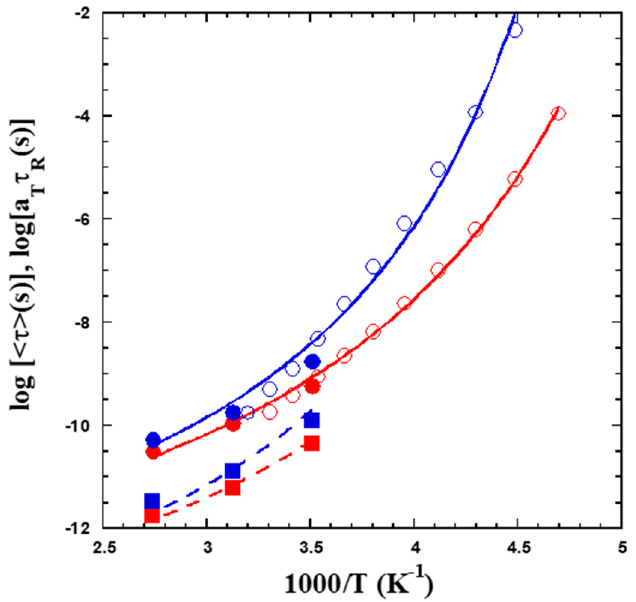
Figure 8. Temperature dependence of the average characteristic times obtained by QENS for a representative Q -value of 0.95 Å − 1 (filled circles) and resulting values of τ s,0 (filled squares). The former have been combined with the corresponding rheological results (empty circles). Lines are fits of VFT functions (see the text).